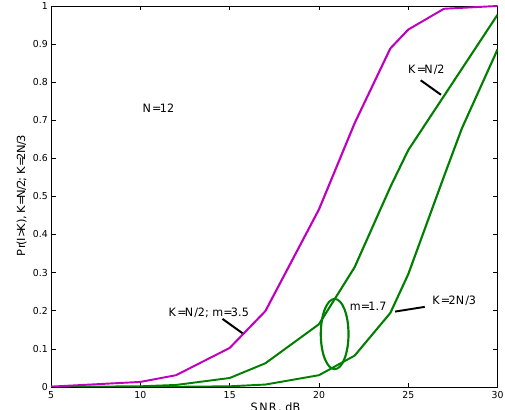
Fig. 1. Complementary CDF, P r{I > K} (N = 12, K = N/2 and K = 2N/3), versus the PU SNR. SUs are uniformly distributed over a circle, and the PU is located at the